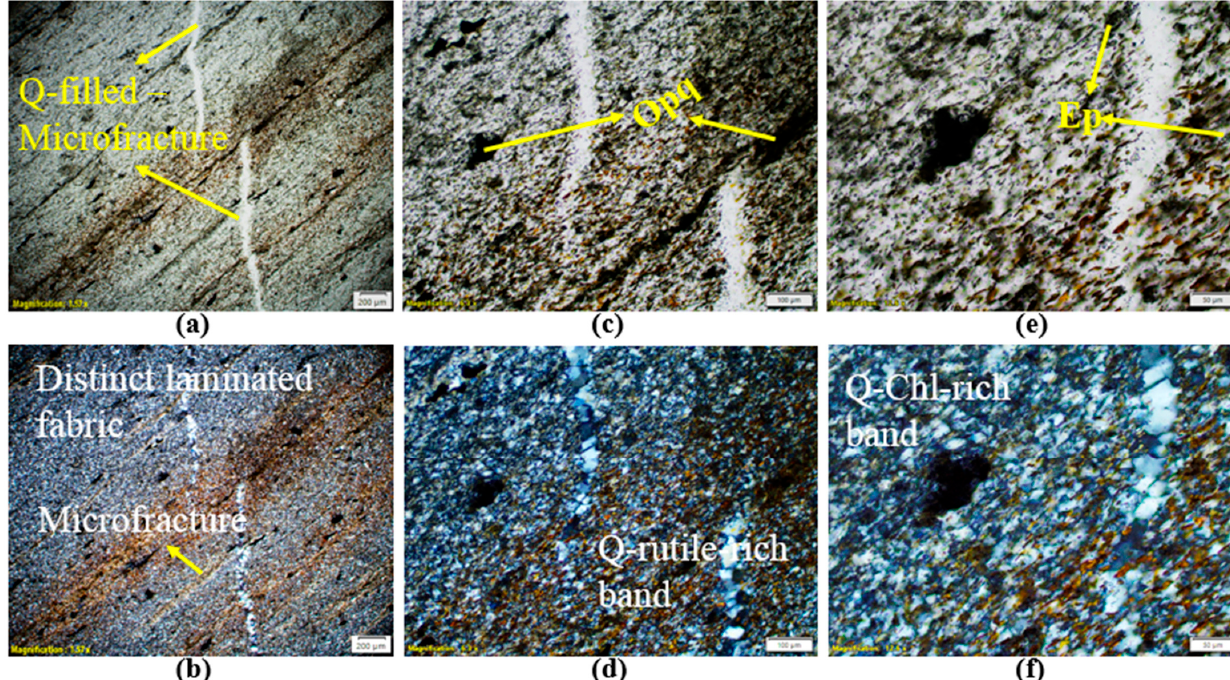
Figure 9. Results of petrographic analysis for microschist sample at 600 °C (S2); images ( a – f ) were taken at different magnifications ( a , b : 1.57×; c , d : 6.3×; e , f : 12.6×). Images ( a , c , e ) were taken using PPL, while images ( b , d , f ) were taken using CPL. Image ( b ) displays very fine-grained laminated texture with segregated light (quartz–chlorite-rich band) and dark (quartz–rutile/biotite-rich band) layering. Tiny, elongated opaque grains (dark) aligned parallel to the foliation plane. Image ( c ) (PPL) and ( d ) (CPL) show that rock predominantly consists of quartz (gray in CPL), together with chlorite, rutile or biotite, minor epidote, and opaque grains (dark). Chlorite (pale greenish) occurs in an extremely fine-grained (microscopic) form, is platy-to-flaky in nature, and chlorite grains show alignment parallel to the foliation plane. Rutile or biotite (Brownish in color) displays a similar mode of occurrence, grain size, and morphology as displayed by chlorite. The epidote is minor, occurs in microcrystalline granular aggregates forming scattered-to-dense disseminations, and locally shows alignment parallel to the foliation plane. Q: quartz; Chl: chlorite; Opq: opaque; Ep: epidote.